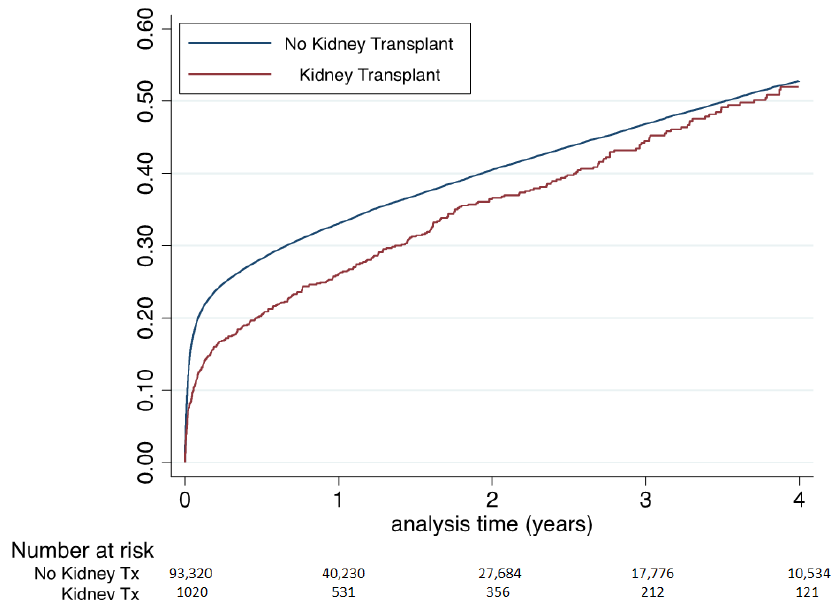
Figure 4. Cumulative incidence of all-cause death in patients seen in French hospitals in 2013